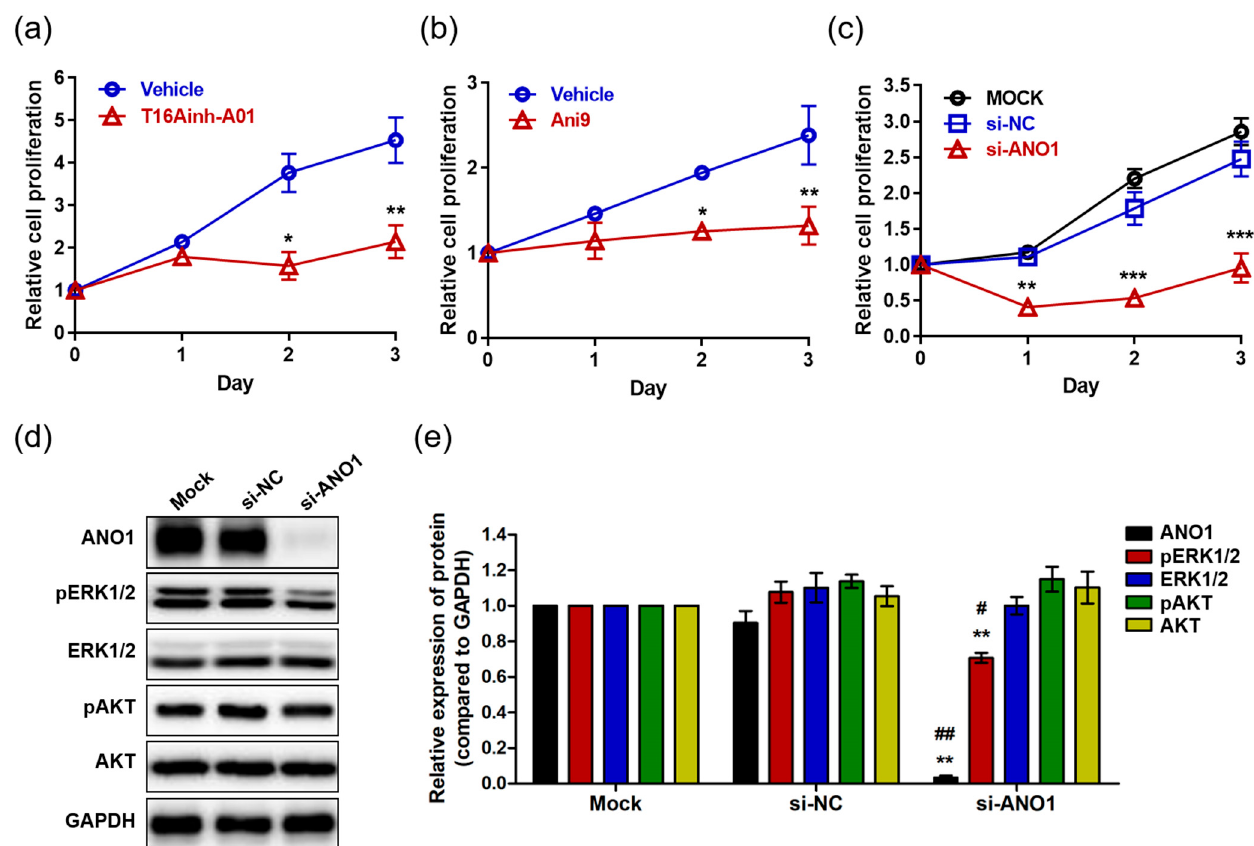
Figure 2. The effects of ANO1 inhibition on HaCaT cells. ( a ) Proliferation of cells exposed to 30 µM T16Ainh-A01 for 3 days. ( b ) Proliferation of cells exposed to 10 µM Ani9 for 3 days. ( c ) Proliferation of cells following ANO1 knock-down for 3 days. After knock-down of ANO1 using siRNA targeting ANO1 and in negative controls (mock and si-NC), proliferation rates of HaCaT cells were measured for 3 days. ( d ) Immunoblots of ANO1 and ERK and AKT signaling pathway-related proteins after ANO1 knock-down for 2 days. ( e ) Densitometric analysis for the relative intensity of ANO1 and ERK and AKT signaling pathway-related proteins. Treatments with the two blockers (T16Ainh-A01 and Ani9) and ANO1 knock-down were performed as four independent replicates to guarantee reliable results. To compare the differences between control (vehicle or Mock [si-NC]) and blocker-treated or ANO1 knock-down cells, two-way ANOVA and Tukey’s post- hoc tests were used. *: significantly different from vehicle in ( a , b ), from Mock and si-NC ( c ), and from Mock ( e ) (* p < 0.05, ** p < 0.01, and *** p < 0.001). # : significantly different from si-NC ( e ) ( # p < 0.05 and ## p < 0.01).